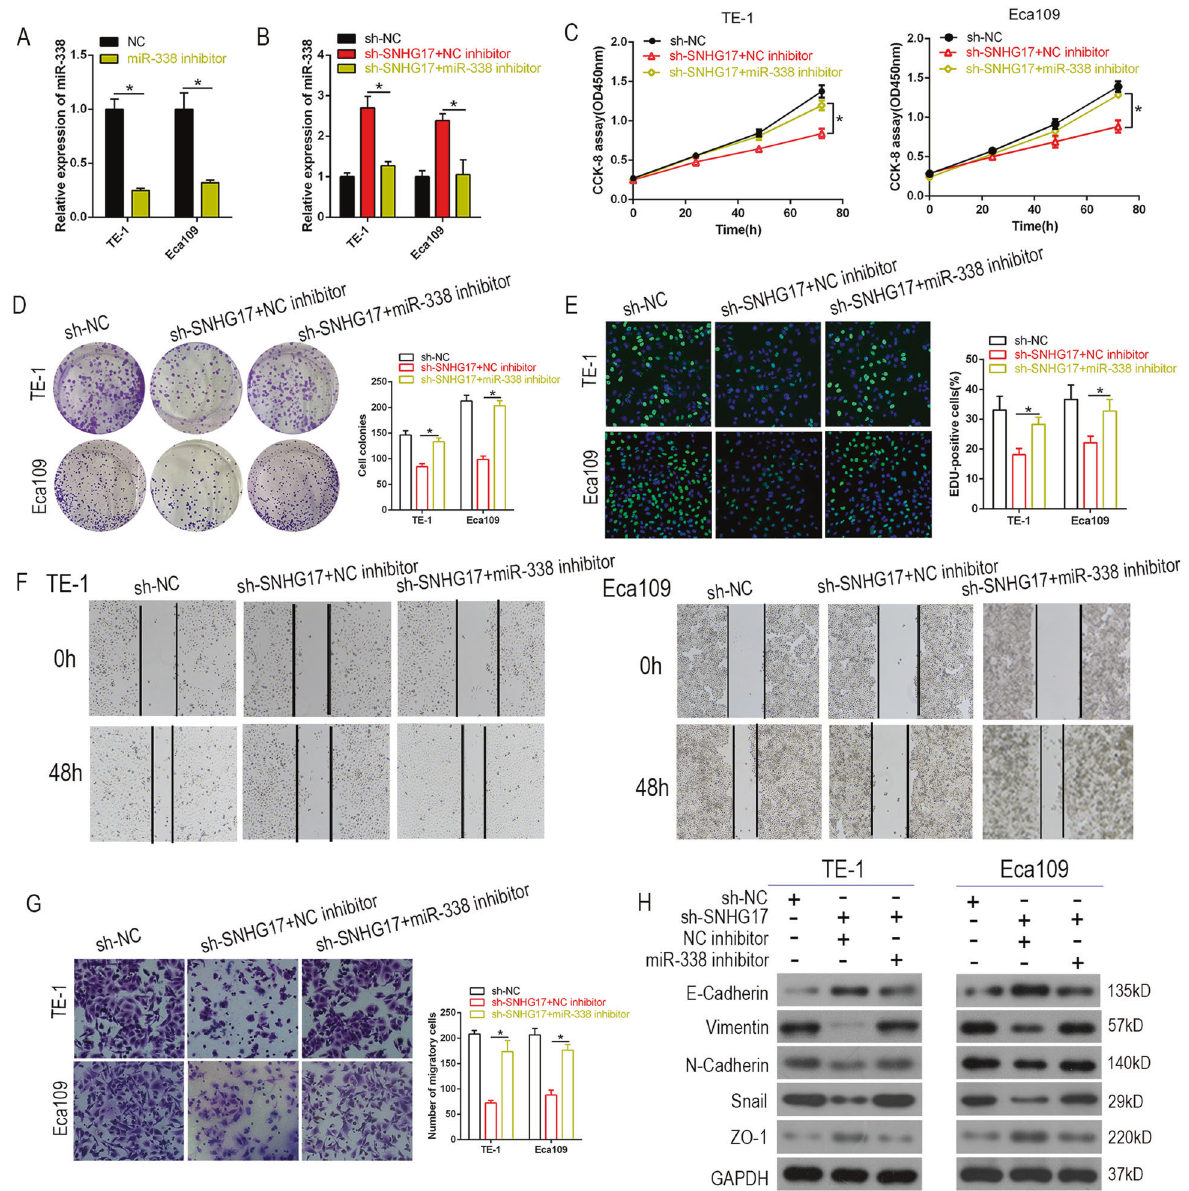
and miR-338 inhibitor. * P < 0.05 vs.